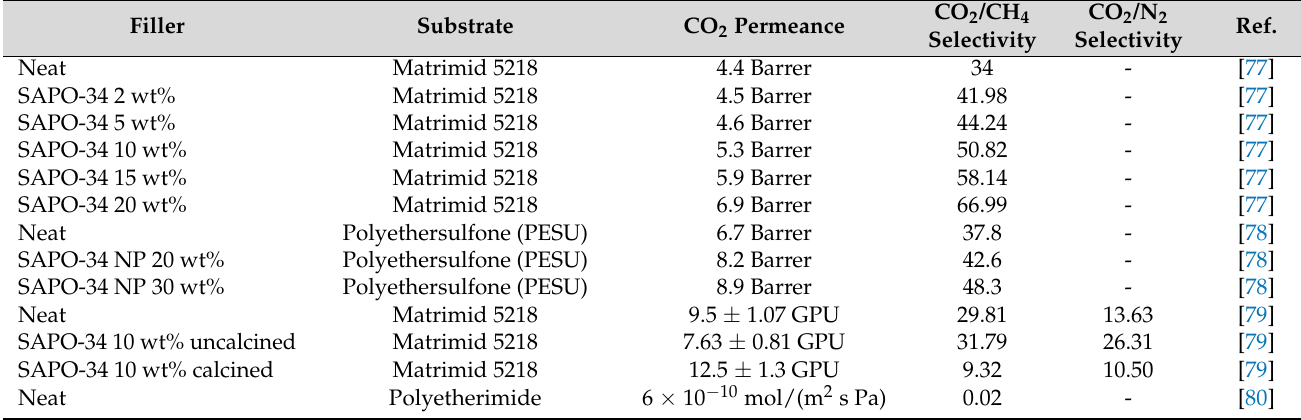
Table 1. Summary of separation performance for SAOP-34 MMMs.